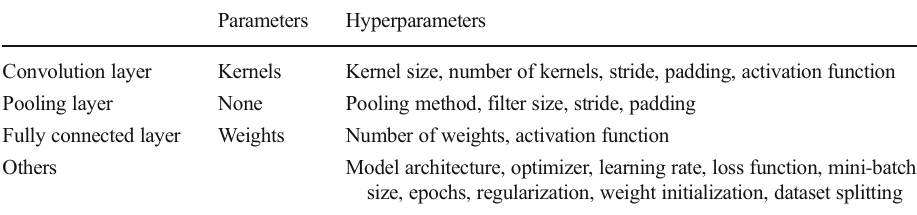
Table 1 A list of parameters and hyperparameters in a convolutional neural network